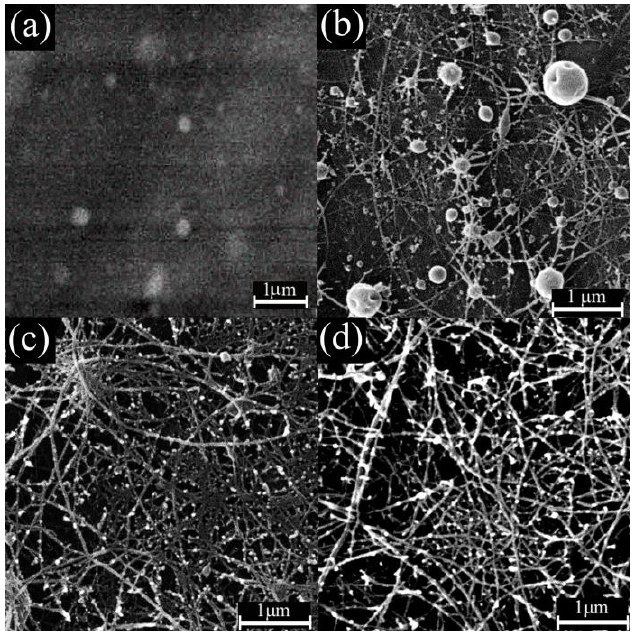
Figure 2. Scanning electron microscopy (SEM) images of ( a ) sulfadiazine modified chitosan electrospun alone SCH; ( b ) SCH and chitosan (CH) separately electrospun through the inner and outer nozzle respectively (SCH-IN); ( c ) SCH and CH separately electrospun through the outer and inner nozzle respectively (SCH-OUT); ( d ) chitosan/sulfadiazine mixture (CH/SDZ) electrospun alone.